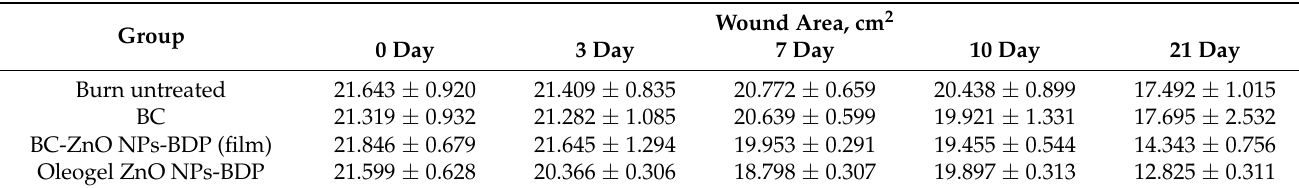
Table 8. Wound area changes during treatment with BC, BC-ZnO NPs-BDP (film), and ZnO NPs-BDP oleogel ( n = 5, p <